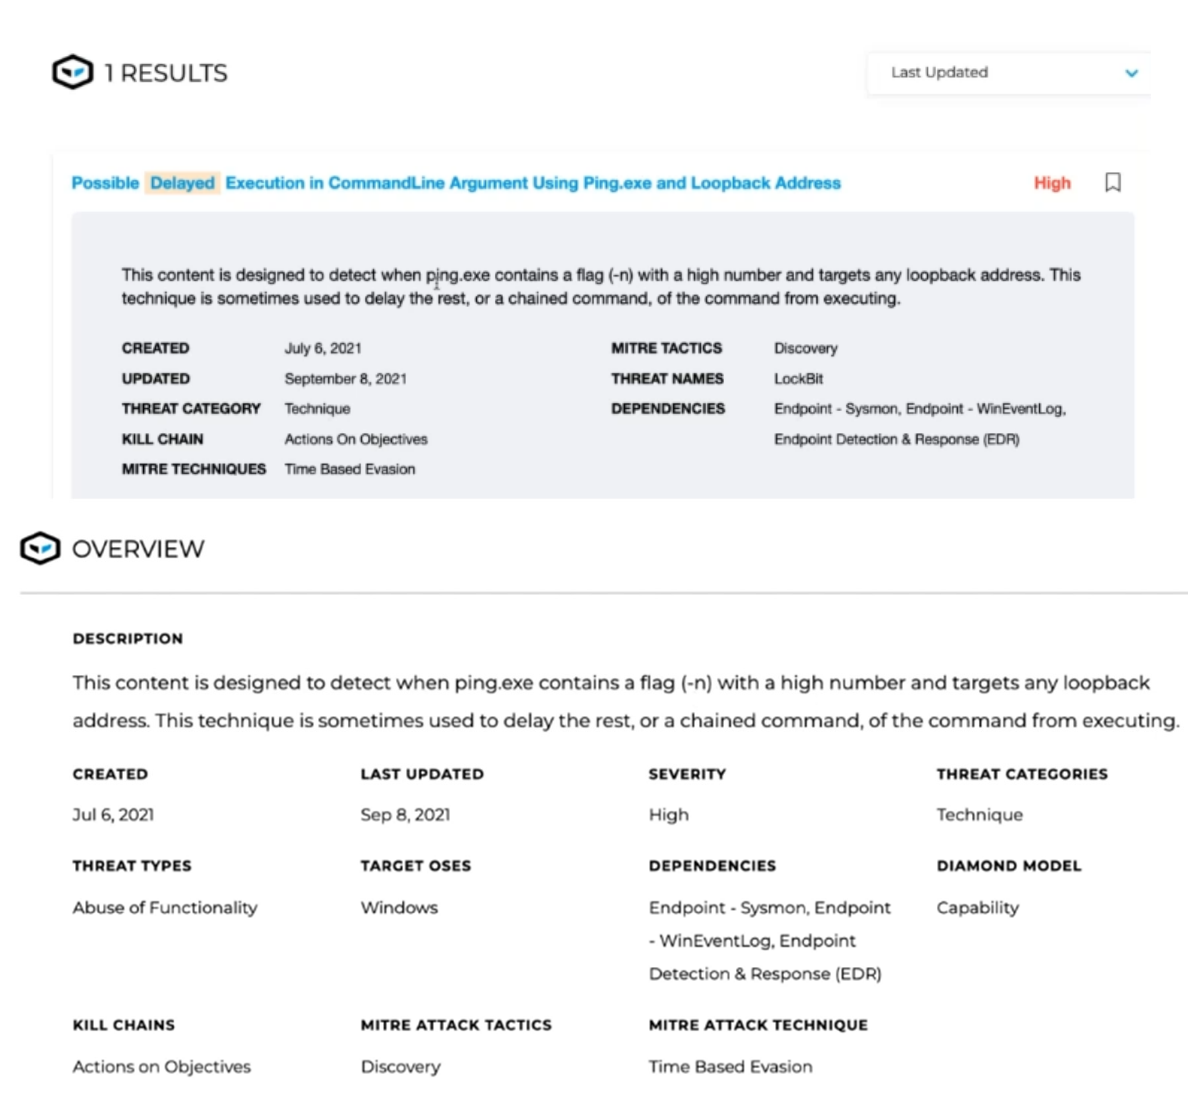
Figure 11. Delayed execution search and overview.